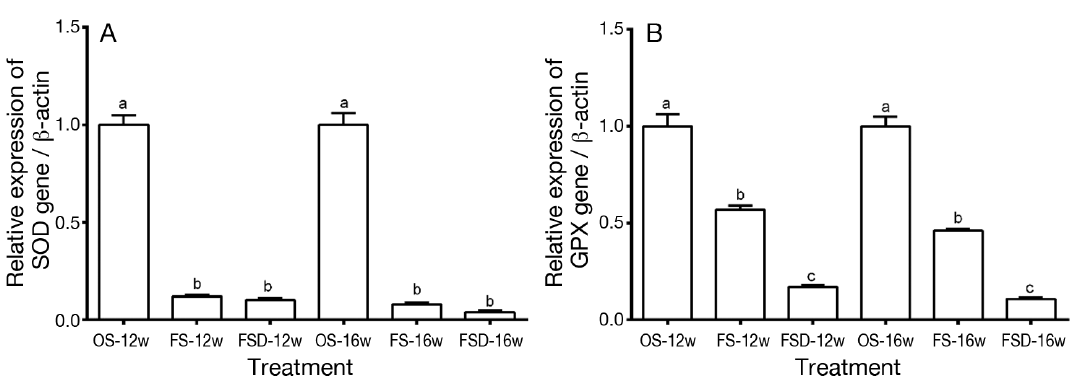
Fig. 2. Real-time quantitative PCR analysis of the relative expression of the genes (A) cMnSOD and (B) GPX (as the amount of the reference gene β -actin, dimensionless) in whiteleg shrimp Litopenaeus vannamei after 12 wk (12w) and 16 wk (16w) in monoculture (OS) fed commercial shrimp diet (10% body weight), shrimp in co-culture with Nile tilapia Oreochromis niloticus but unfed (FS), shrimp in co-culture co-fed on commercial shrimp (2.5%) diet (FSD). Data are mean + SEM (n = 9 in triplicate). Means with different superscripts are significantly different from the monoculture treatment (p ≤ 0.05)